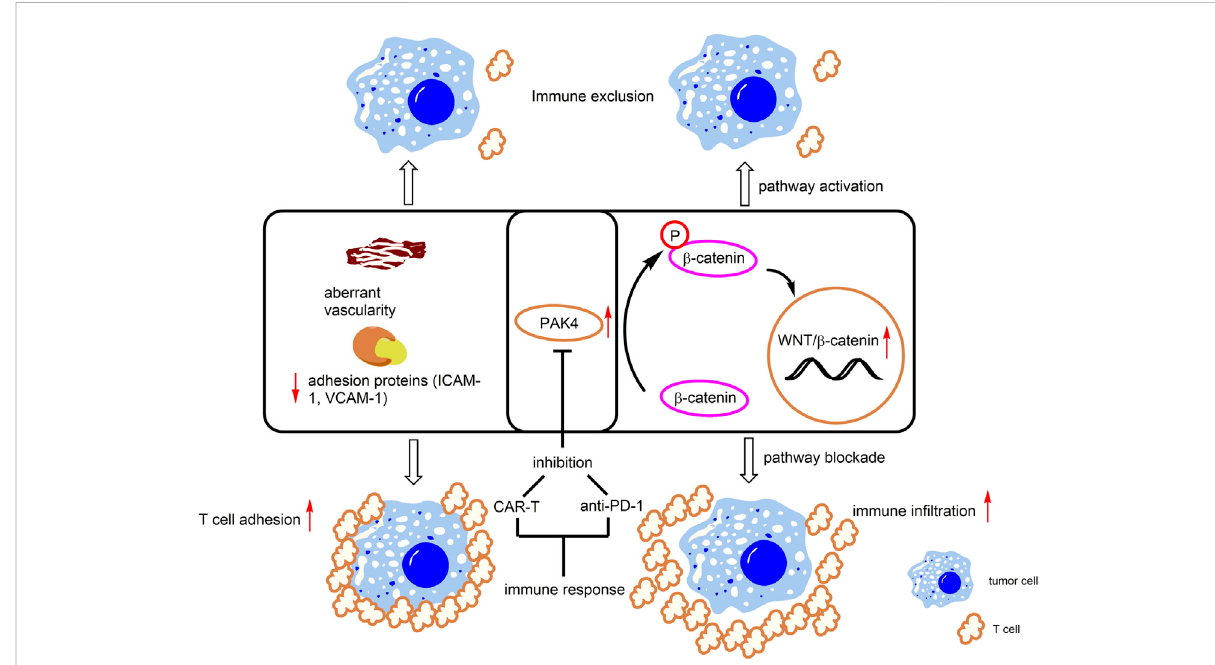
FIGURE 5 PAK4-mediated immune responses. Overexpression of PAK4 induces β -catenin phosphorylation and activates the WNT/ β -catenin pathway. In addition, PAK4 decreases levels of T cell related adhesion protein (ICAM-1, VCAM-1) and induces aberrant vascularity. These events lead to immune exclusion. Knockdown or pharmacological inhibition of PAK4 promotes T cell in fi ltration and immunotherapeutic